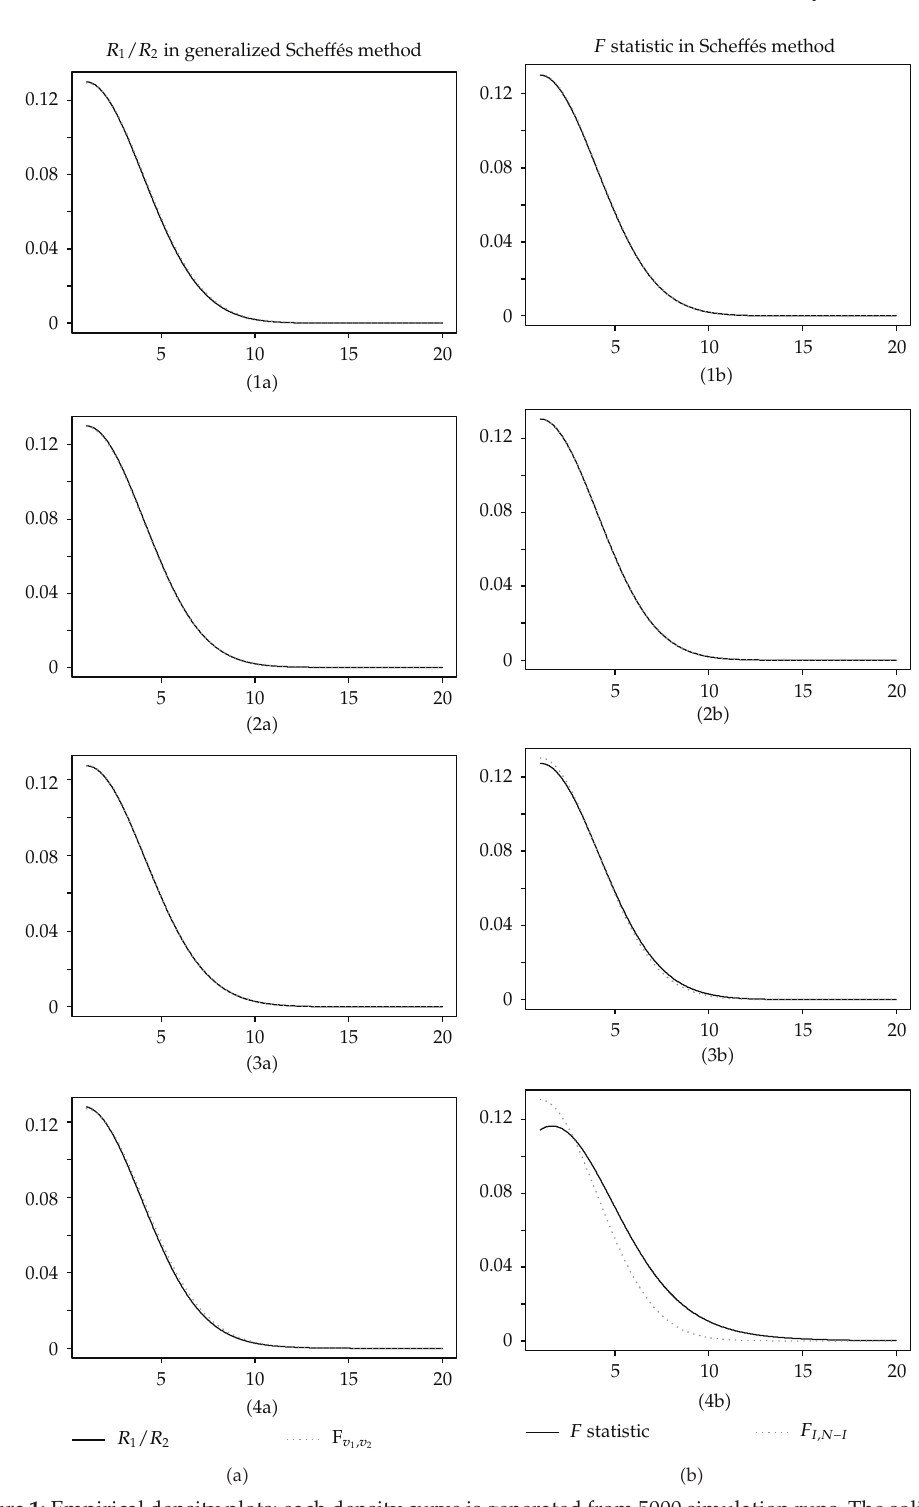
Figure 1: Empirical density plots: each density curve is generated from 5000 simulation runs. The solid line is for the F statistic or R 1 /R 2 and the dotted line is for their designated F